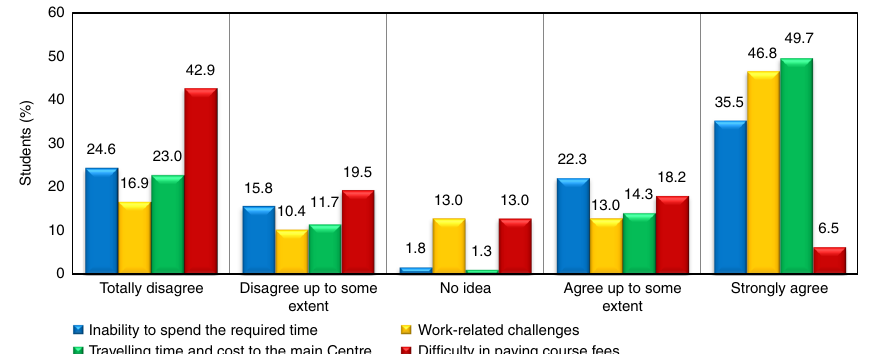
Figure 4. Student-related personal barriers rated as significant for on-time completion of